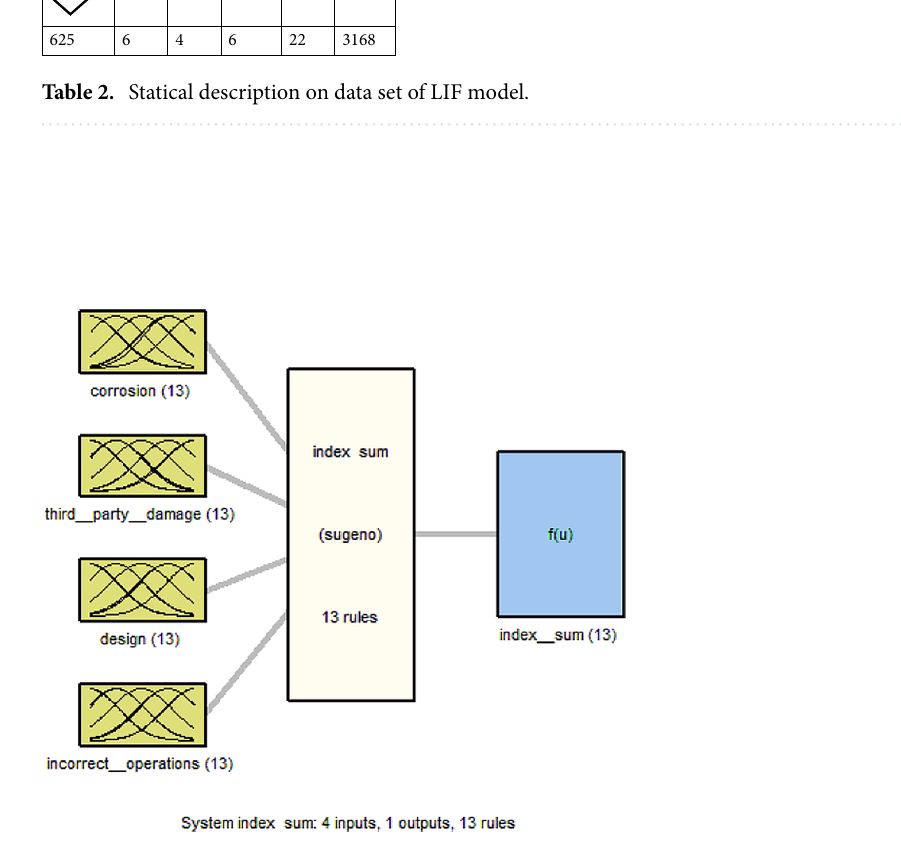
Figure 5. Index sum fuzzy inference